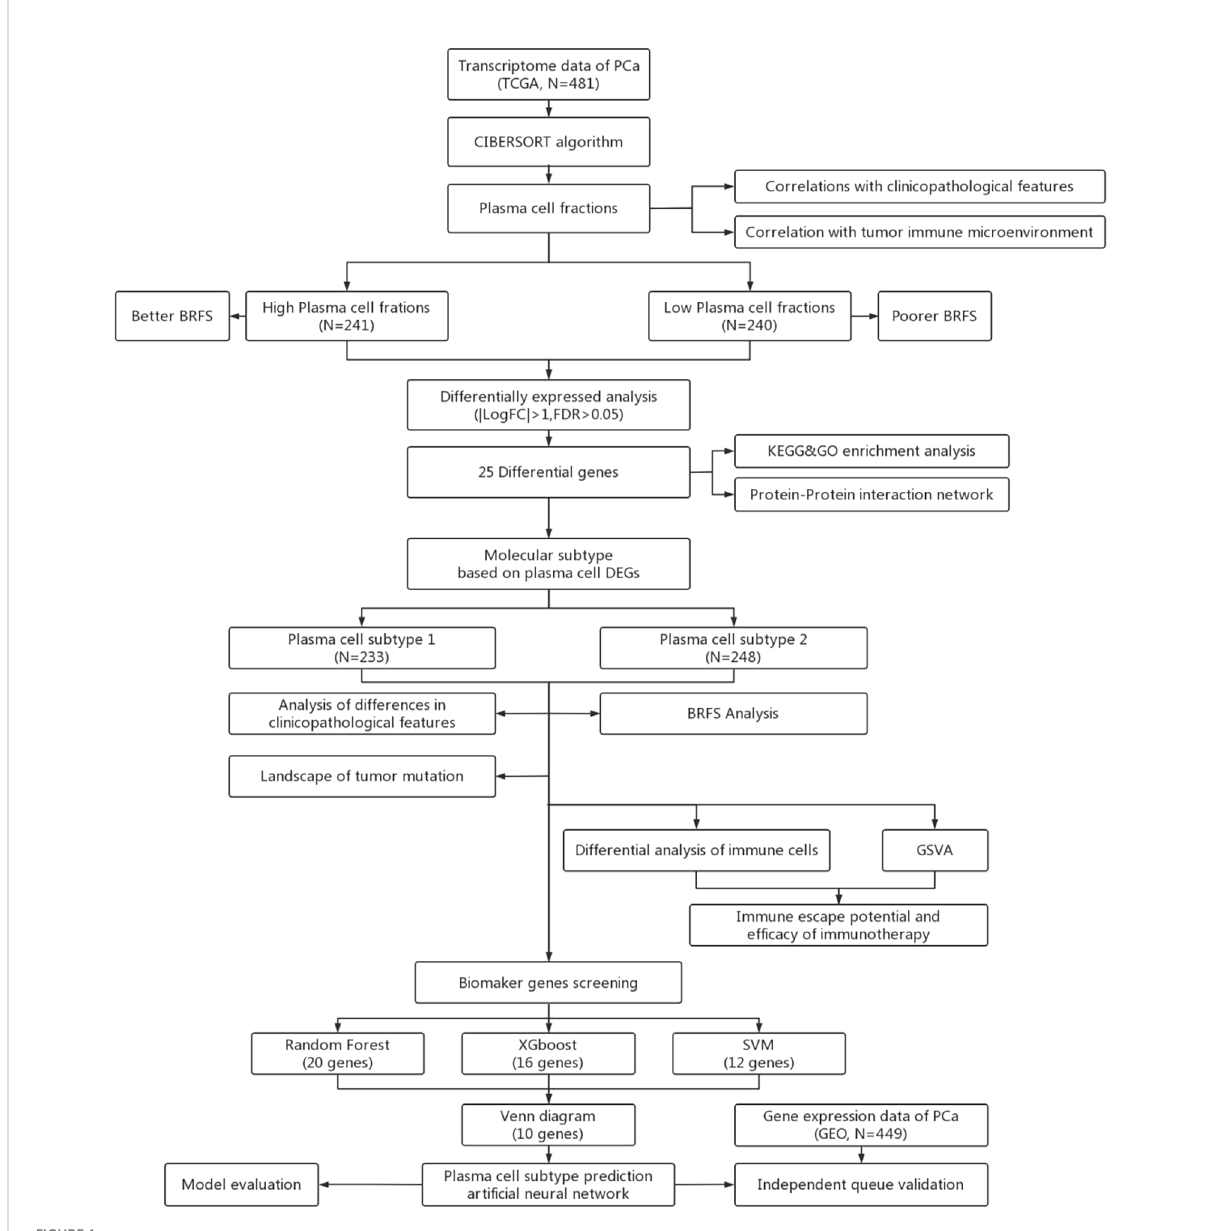
FIGURE 1 Work fl ow for analysis of plasma celle subtypes using arti fi cial intelligence algorithms, (BRFS, Biochemical recurrence-free survival. DEGs, Differentially expressed genes; GSVA, Gene set varation